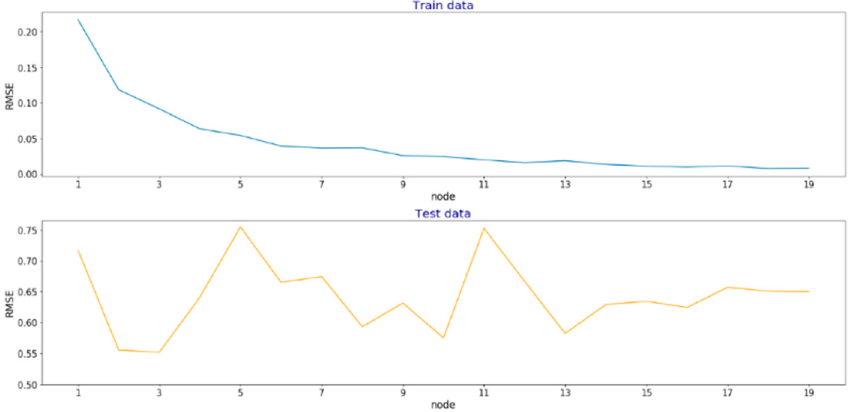
Figure 20. RMSE according to node value.